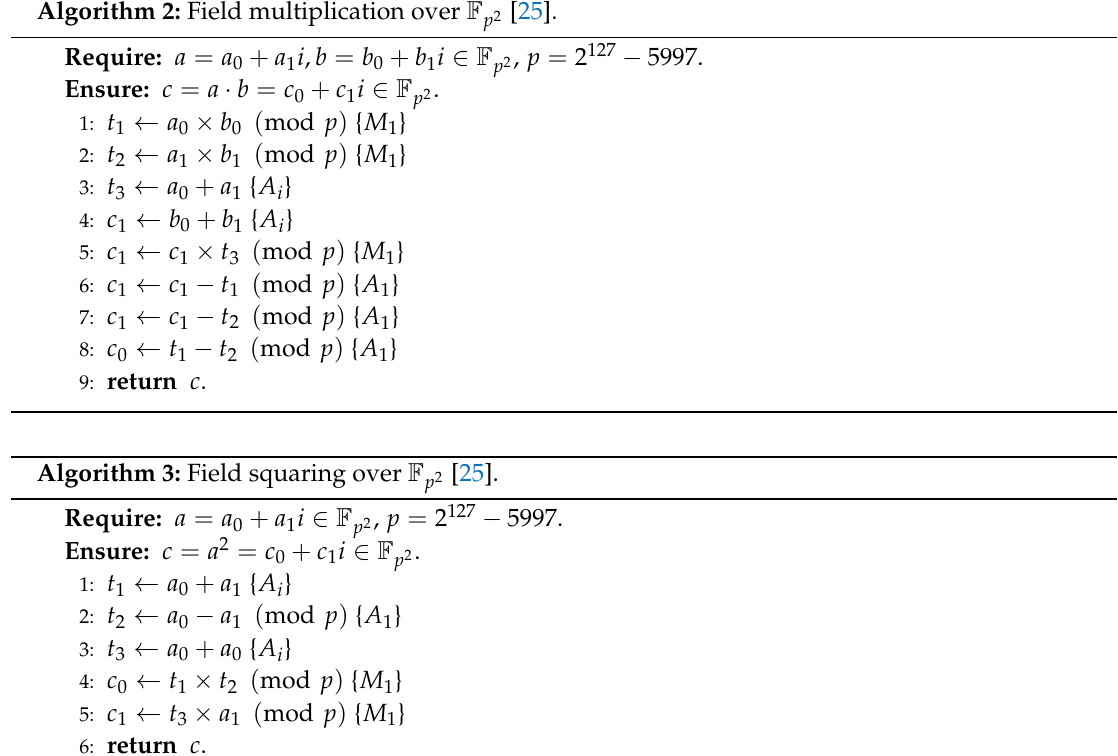
Algorithm 2: Field multiplication over F